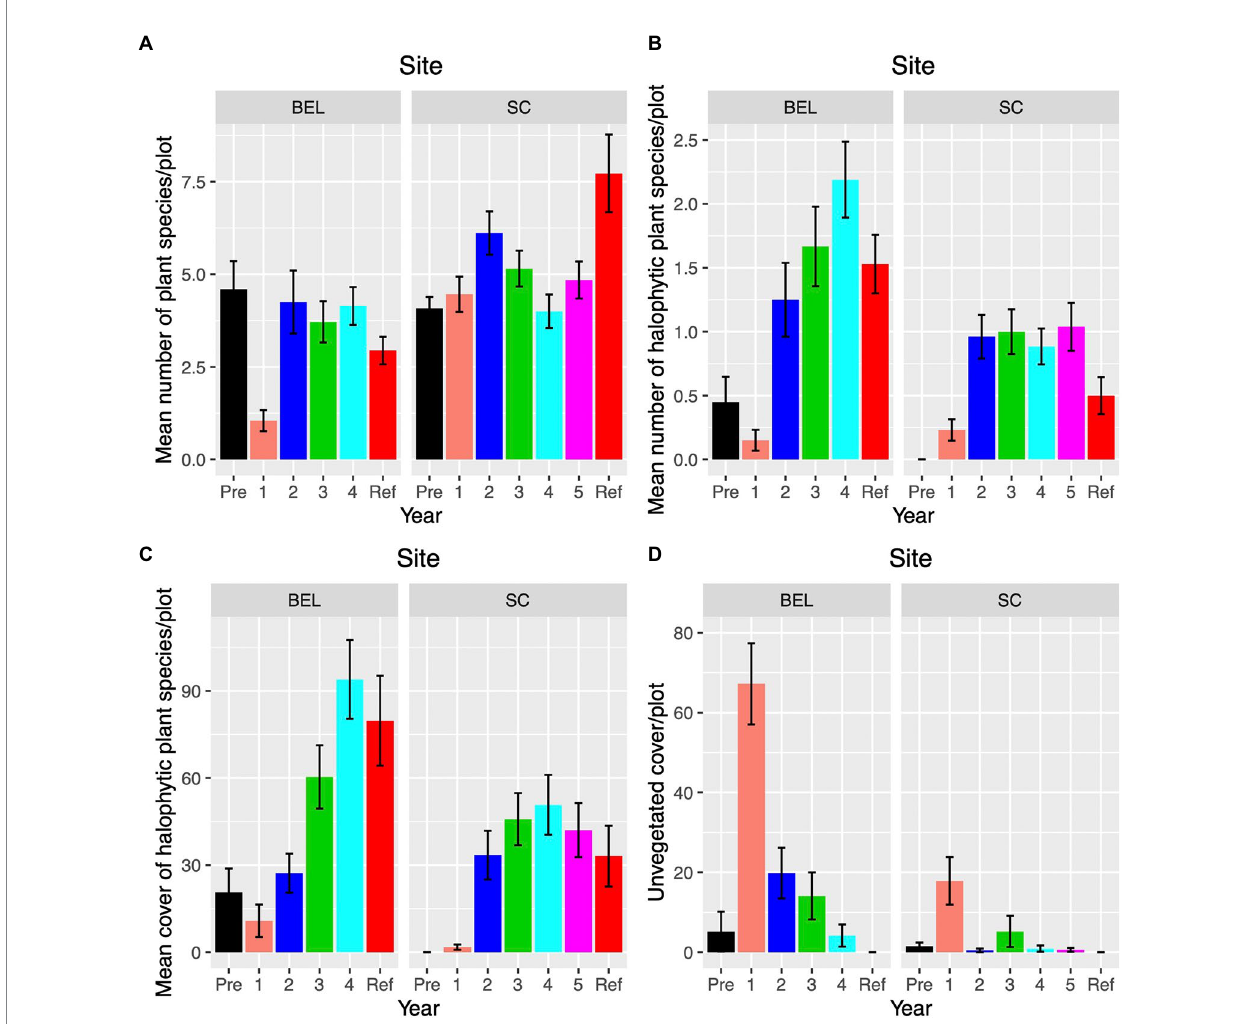
FIGURE 11 Vegetation plot (1m 2 ) changes over time at BEL and SC restoration sites. “Ref” indicates the reference site corresponding to each restoration site; (A) Average plant species richness. (B) Average halophytic species richness; (C) Average halophytic species cover; (D) Average unvegetated